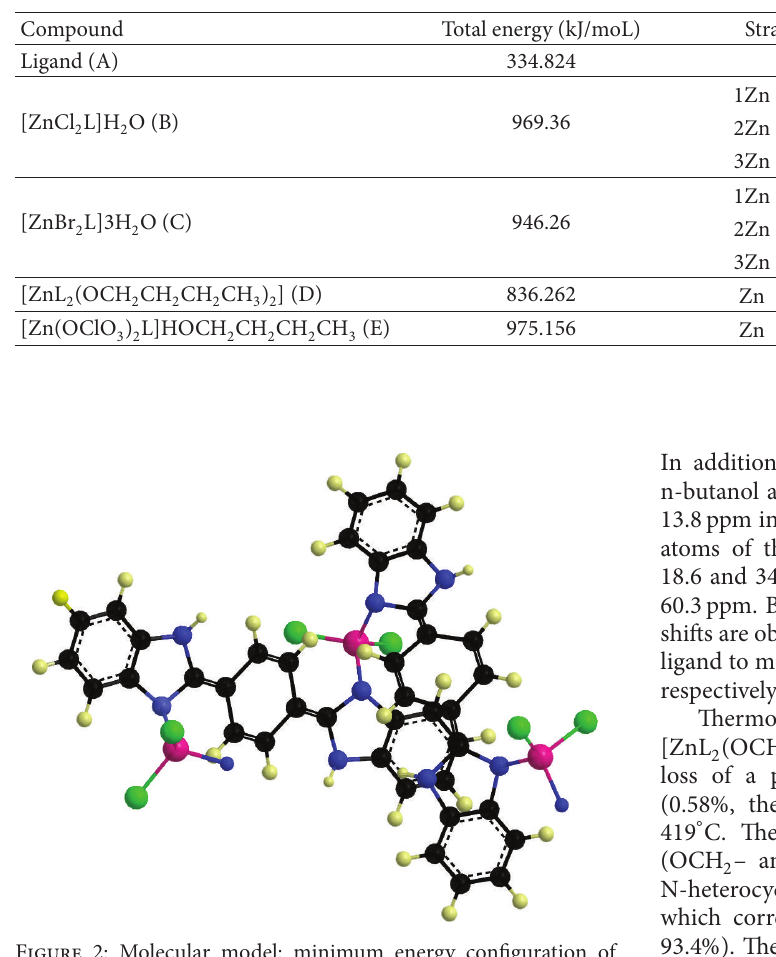
T 4: Molecular modeling data.